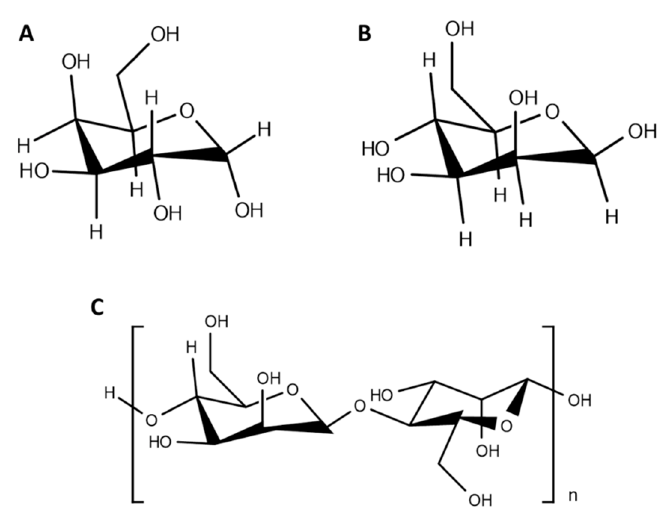
Figure 3. Chemical structure of some carbohydrates commonly used to produce glyconanoparticles. ( A ) Galactose; ( B ) mannose; ( C ) mannan.